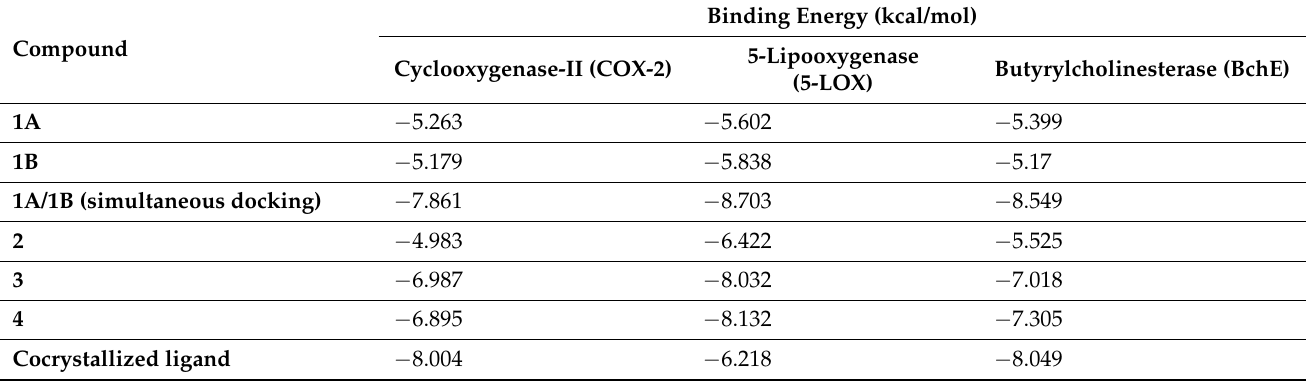
Table 4. Docking scores of compounds ( 1A / 1B and 2 – 4 ) against COX-2, 5-LOX, and BchE enzymes using AutoDock Vina